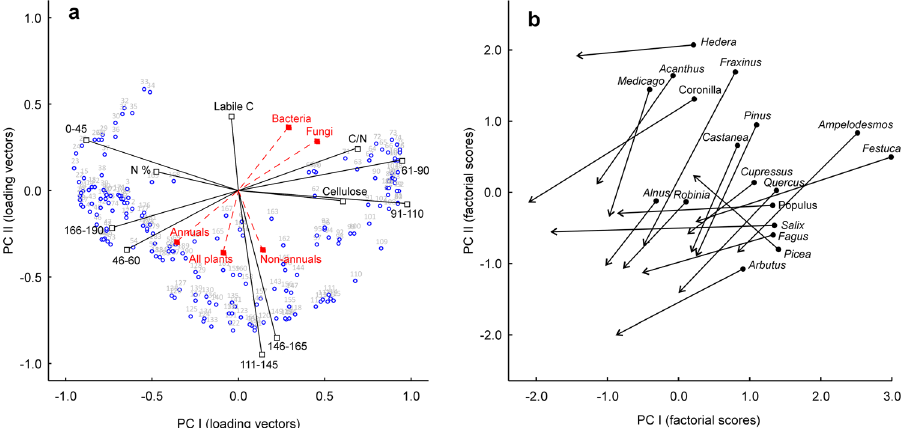
Figure 5. Principal component analysis of 13 C NMR spectral signals recorded in 36 litter types (i.e. fresh and decomposed leaf materials from 18 plant species) in relation to growth response of plants and microbes and litter biochemical quality and age. ( a ) Loading vectors of spectral signals. Litter biochemical parameters and reference spectral regions (black vectors), as well as growth response of target organisms, averaged for bacteria, fungi, and annual, non-annual, and all plants (red vectors) are plotted as supplementary variables (Legendre and Legendre 75 ). ( b ) Factorial scores of litter types, with decomposition trajectories between 0 and 180